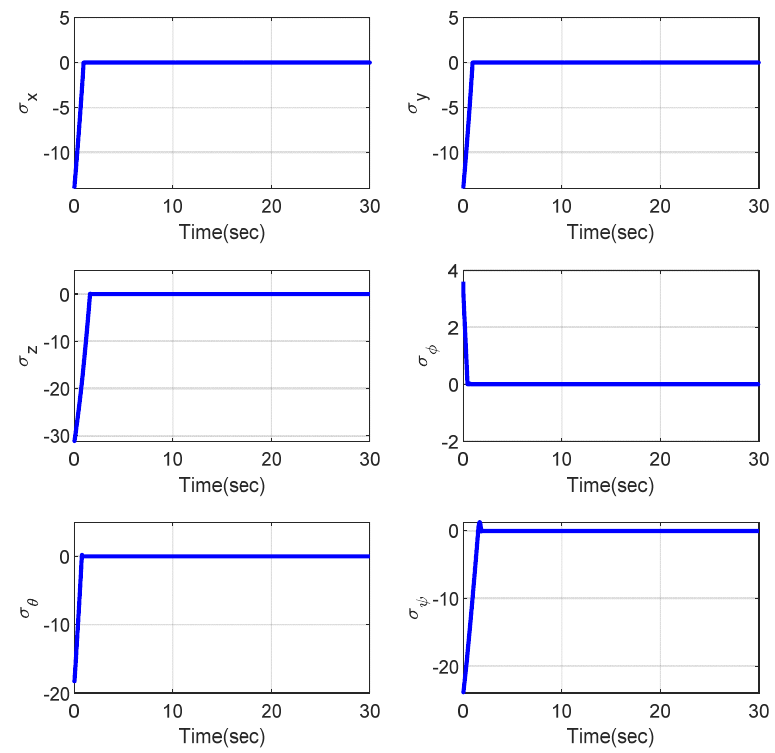
Figure 6. Time responses of the non-singular terminal sliding surface.